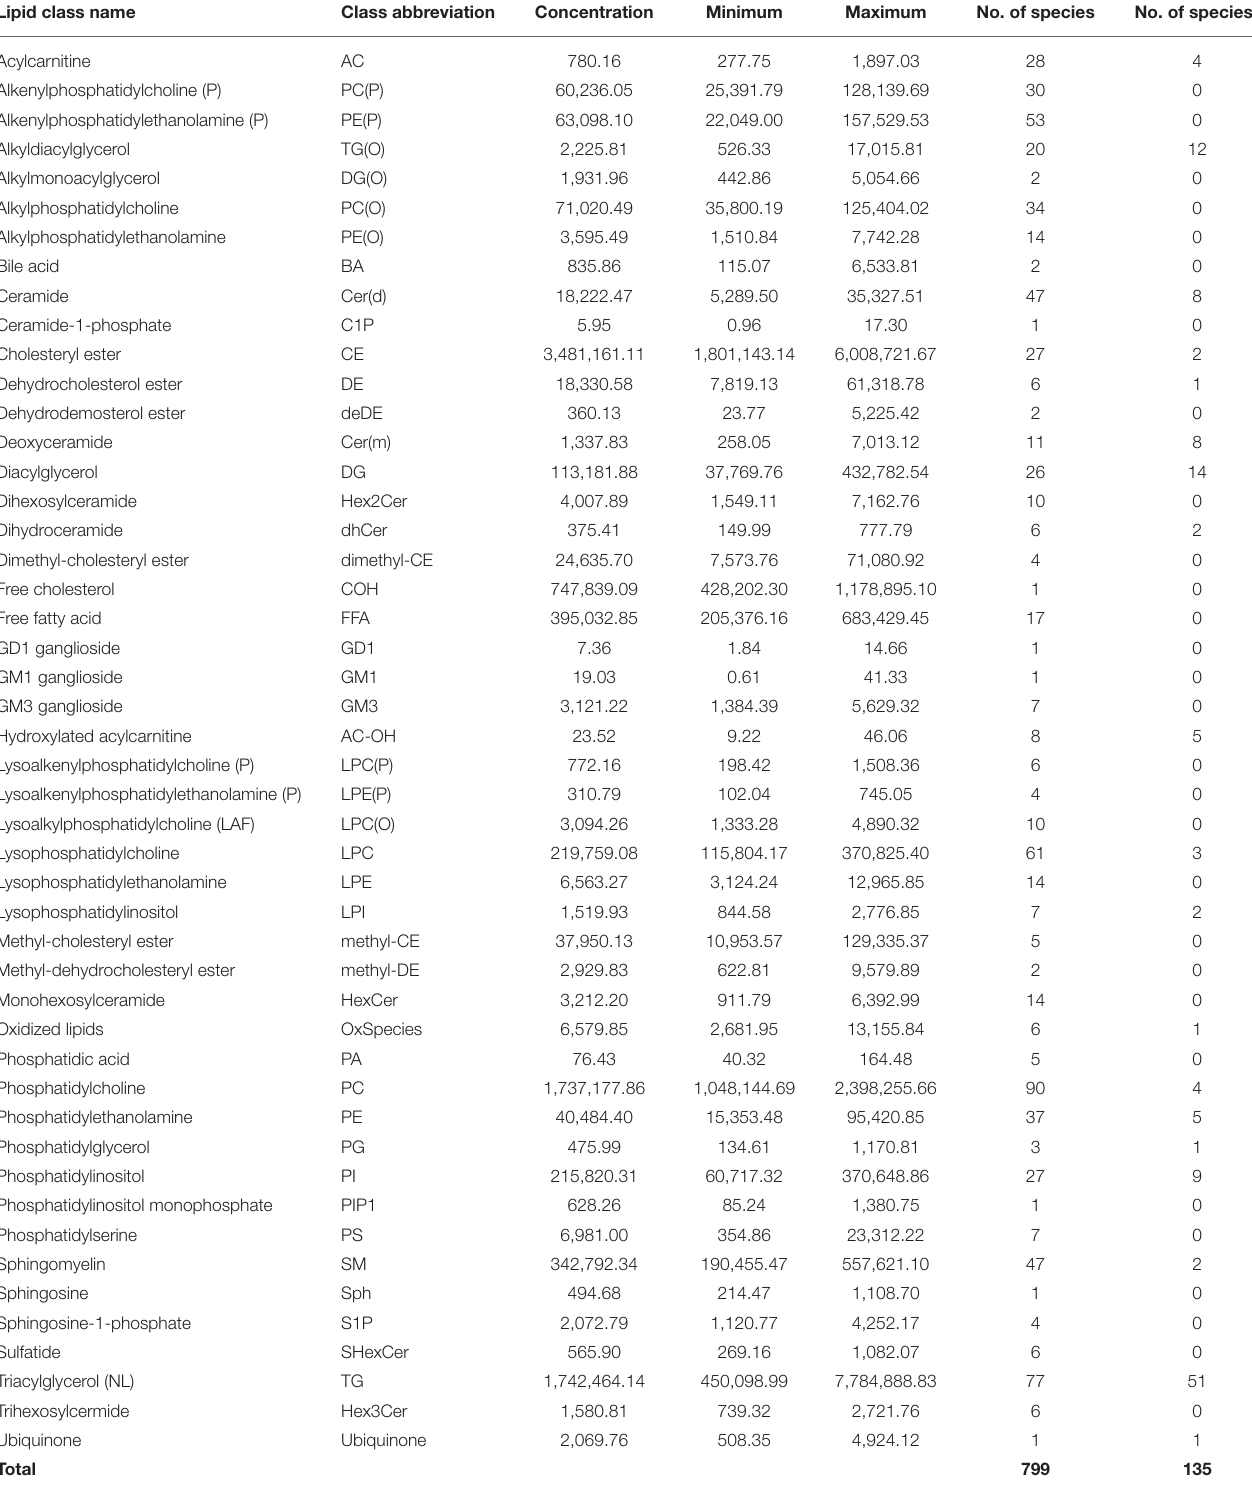
TABLE 2 | Lipid classes assessed by targeted lipidomics: concentration (pmol/mL), range of concentration (maximum and minimum, pmol/mL) and associations with EAT volume. Lipid class